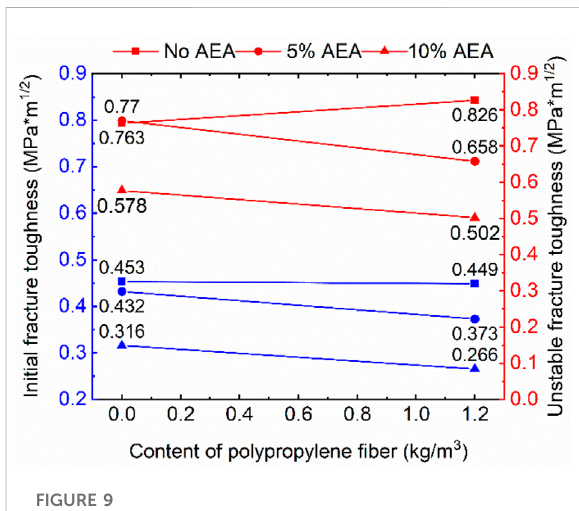
FIGURE 9 Effect of polypropylene fi ber on unstable fracture